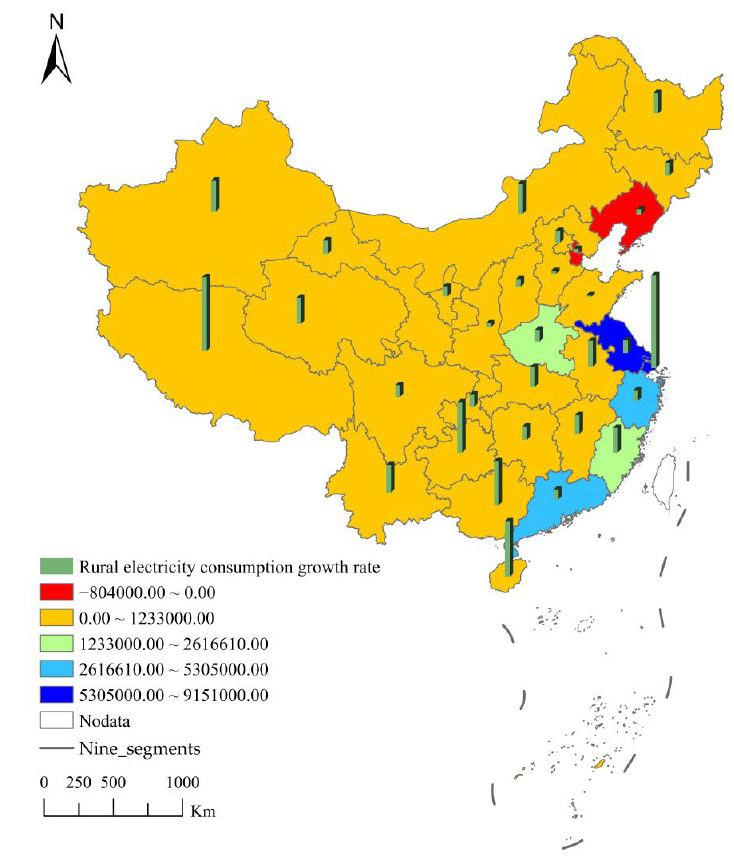
Figure 3. Spatial pattern of the absolute growth rate and the average annual growth rate of rural electricity consumption from 2007 to electricity consumption from 2007 to 2020.